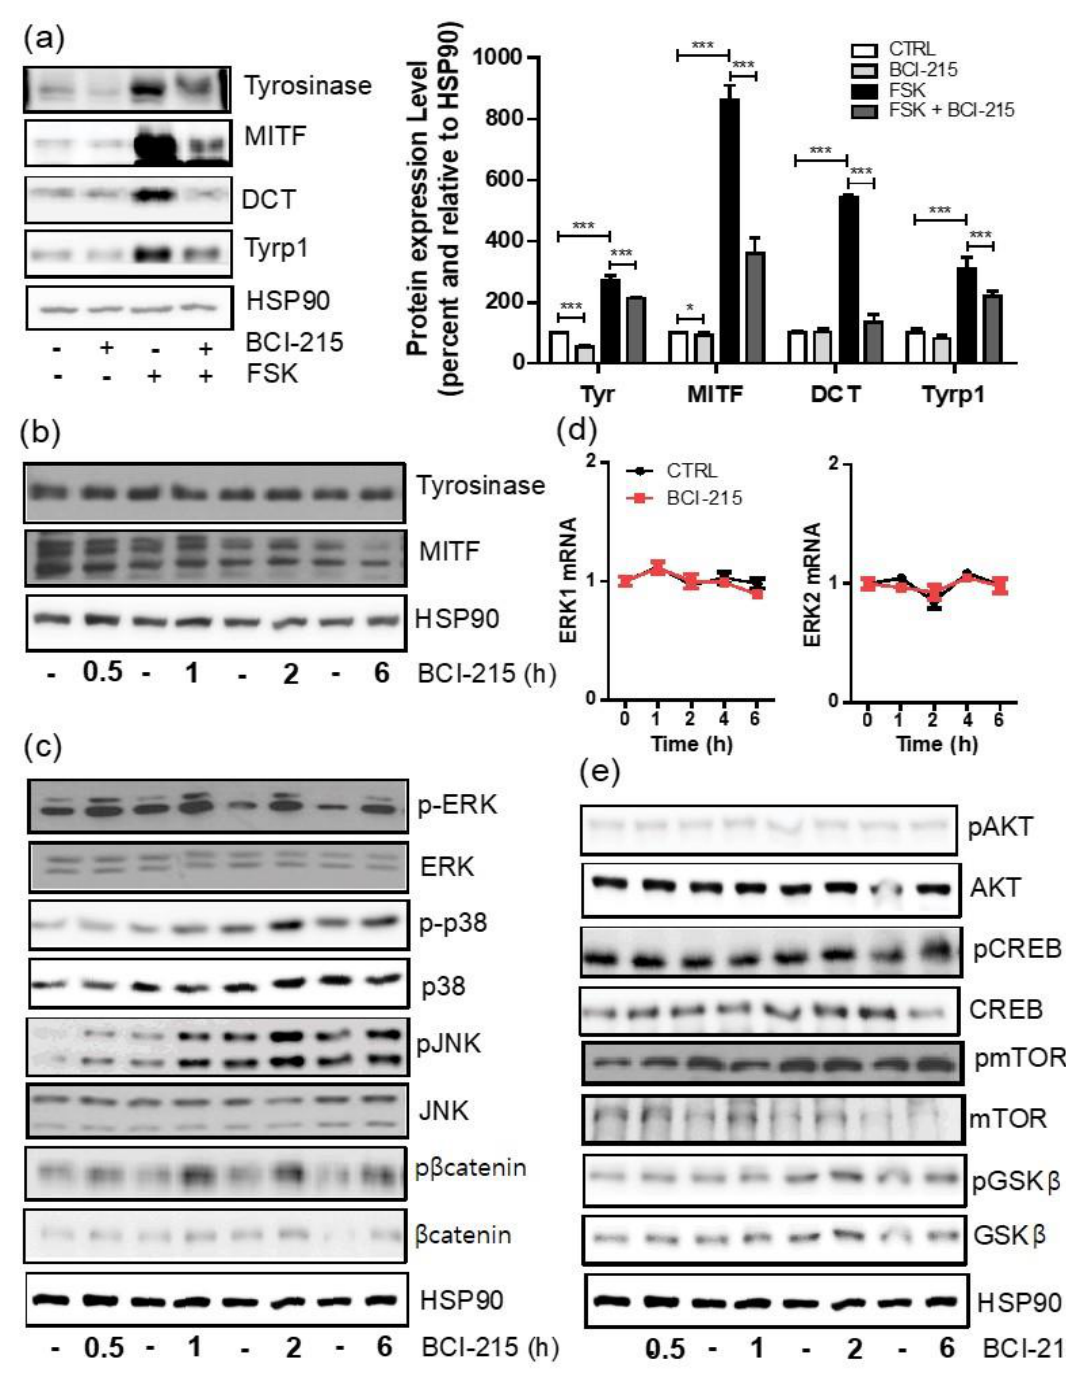
Figure 4. Effect of BCI-215 on the translation of MITF and its downstream genes and intracellular signaling expression. ( a ) Immunoblotting ( n = 5) of MITF, Tyrp1, tyrosinase, and DCT 48 h after a treatment with 1 μM BCI-215 in a basal or FSK-stimulated condition. Quantitative data in the right panel. ( b ) Immunoblotting ( n = 5) of MITF and tyrosinase up to 6 h after a treatment with BCI-215. ( c ) Protein expression ( n = 10) of intracellular signaling pathways for the MAPKs, including total or phosphorylated forms of ERK, JNK, p38, and β -catenin after a 1 µ M BCI-215 treatment at an indicated time. ( d ) Relative mRNA expression of ERK1/2 up to 6 h after exposure to 1 µM BCI-215. ( e ) The protein levels ( n = 5) of the total or phosphorylated forms of mTOR, CREB, GSK- β , and AKT. – means control for each time point. * p < 0.05, *** p < 0.001 vs. controls. 2.4. BCI-215 Induces the Activation of All MAPKs, Including ERK, JNK, and p38 in Mel-Ab Cells protein and a subsequent decrease in melanogenesis, we further investigated whether MAPKs or other intracellular signaling pathways were altered by a BCI-215 treatment [15]. The phosphorylation of ERK and JNK was immediately upregulated and maintained